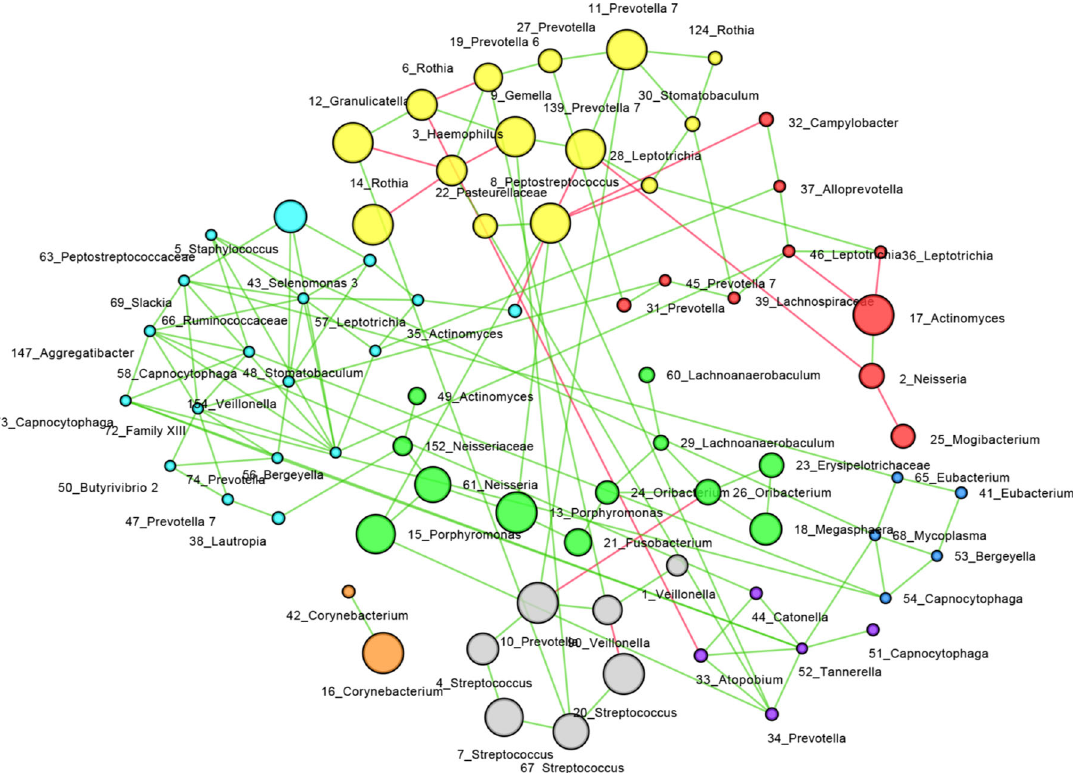
Fig. 4 Microbial co-occurrence network. Microbial interactions were inferred with SPIEC-EASI algorithm using “ MB ” neighborhood selection procedure. Each node represents an OTU. The green edges represent positive correlation between taxa and the red ones represent negative correlation. The diameter of the node corresponds to the relative abundance of the OTU. Clusters in the network were identi fi ed using the Girvan-Newman clustering algorithm. The nodes in one cluster are labeled in the same color. The number in the name of each node represents its OTU